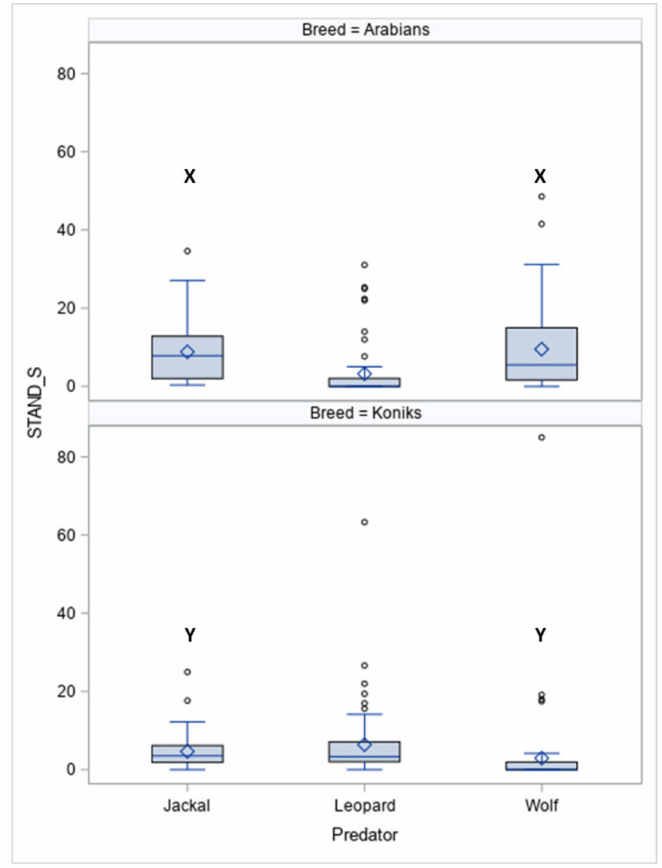
Figure 3. Duration of standing still (STAND-S, %) in Arabians and Koniks exposed to the vocalisation of the jackal, leopard and wolf. Values with X, Y letters di ff ers significantly at p < 0.05 between breeds; values with no letter do not di ff er to other